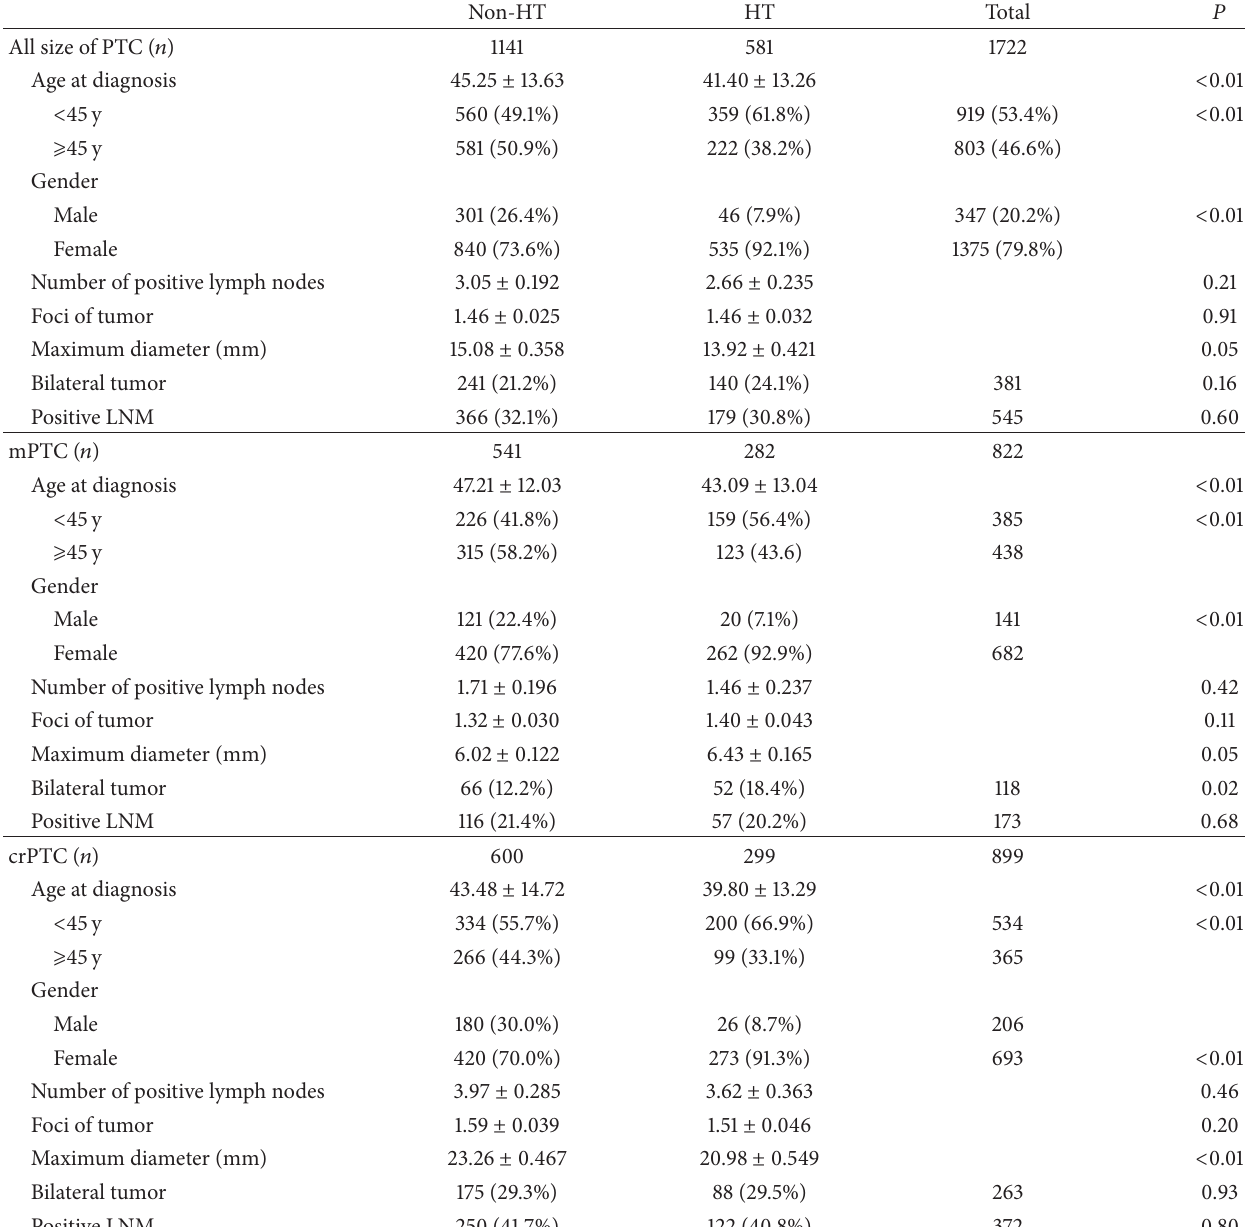
Table 4: Baseline data of PTC (mPTC and crPTC) between non-HT and HT